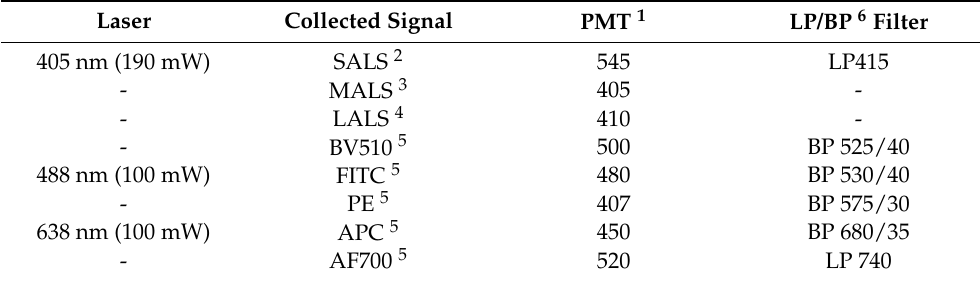
Table 2. Settings for Apogee A60 Micro-PLUS high-resolution flow cytometer. Laser Collected Signal PMT 1 LP/BP 6 Filter 405 nm (190 mW) SALS 2